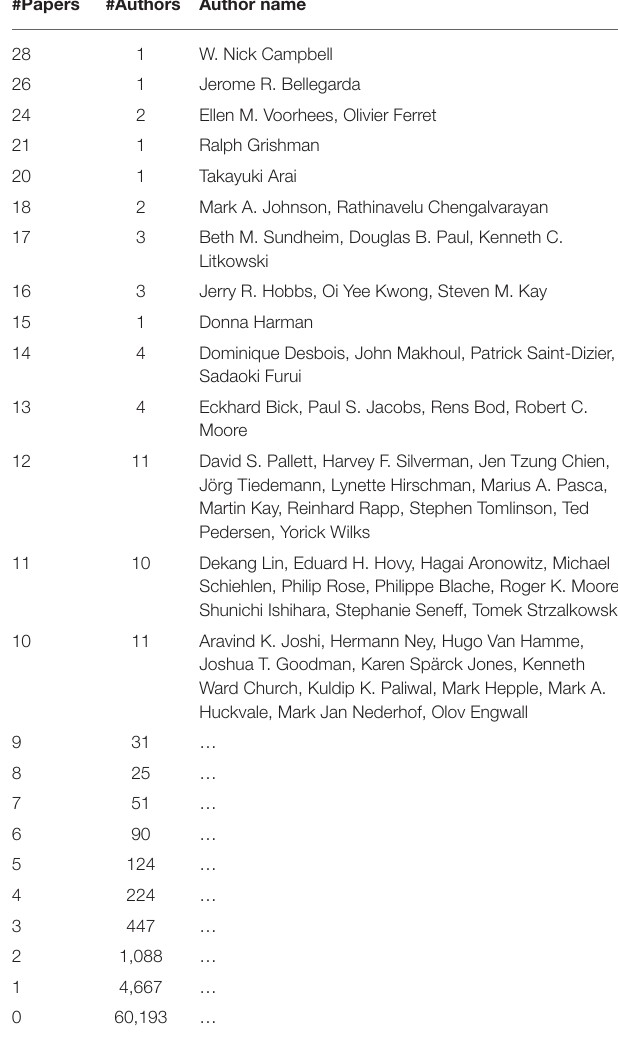
TABLE 5 | Number and names of authors of single author